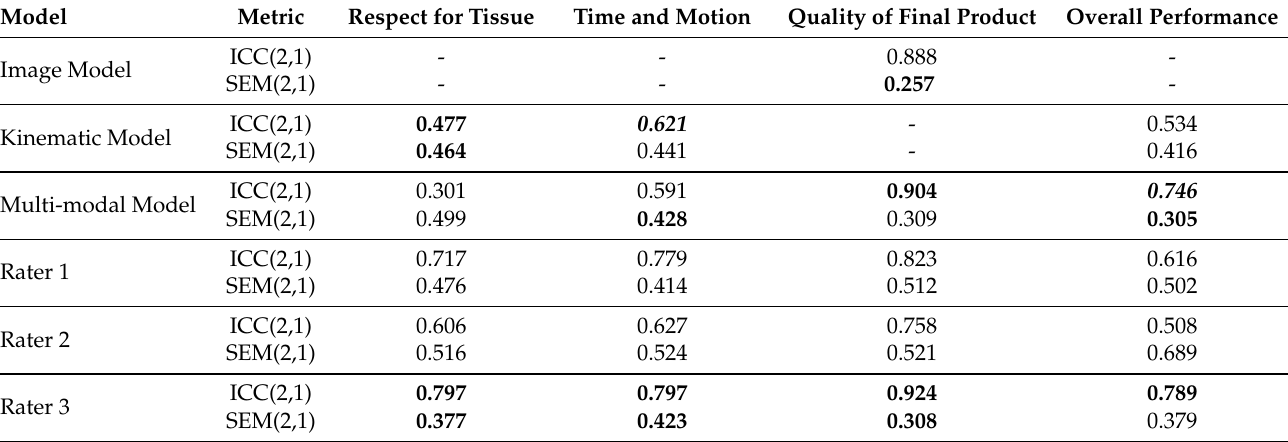
Table 7. Intraclass Correlation Coefficient (ICC) and Standard Error of Measurement (SEM) scores between the ground truth and the AI models & human raters.